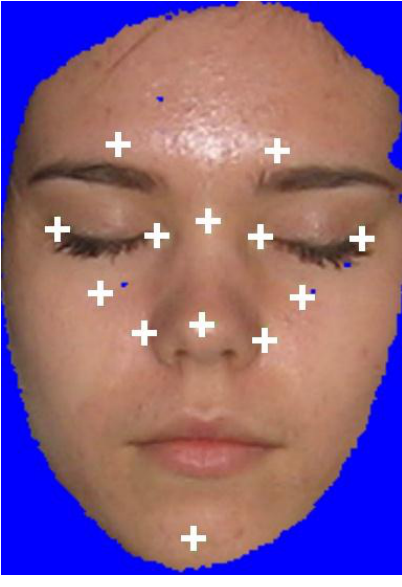
Figure 6. Set of anthropometric points